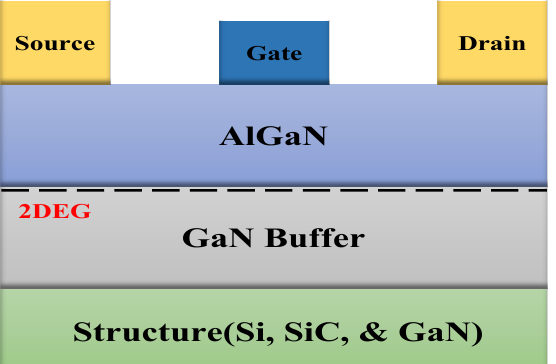
Figure 14. AlGaN/GaN HEMT layout and 2DEG generated in AlGaN/GaN contact are shown by the dashed line.